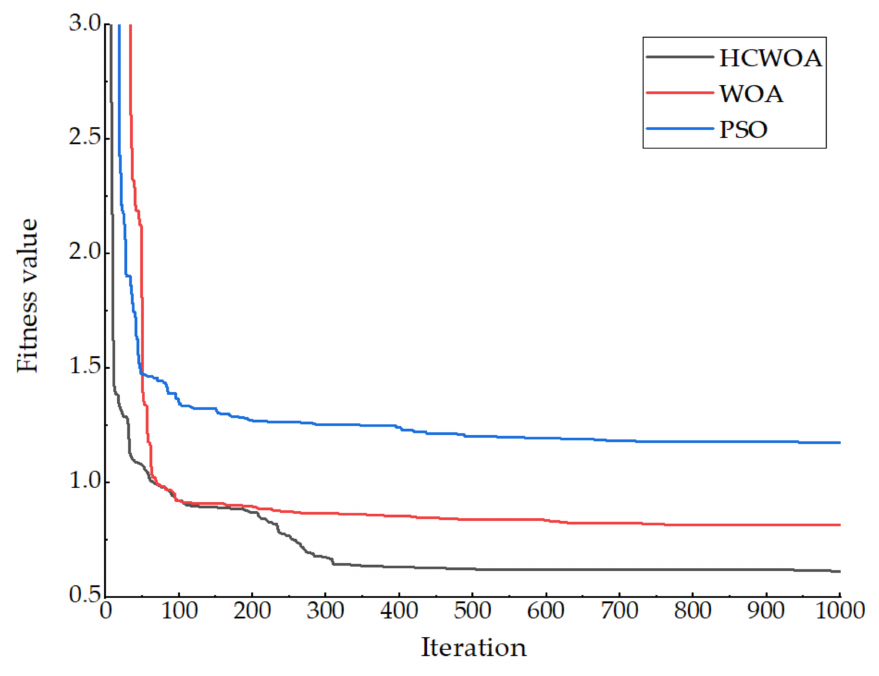
Figure 9. Evolution curves of the fitness value for min L . Corresponding to the optimal fitness value of each optimization algorithm, the modi- fied comparison matrices are generated automatically, and the results of consistency